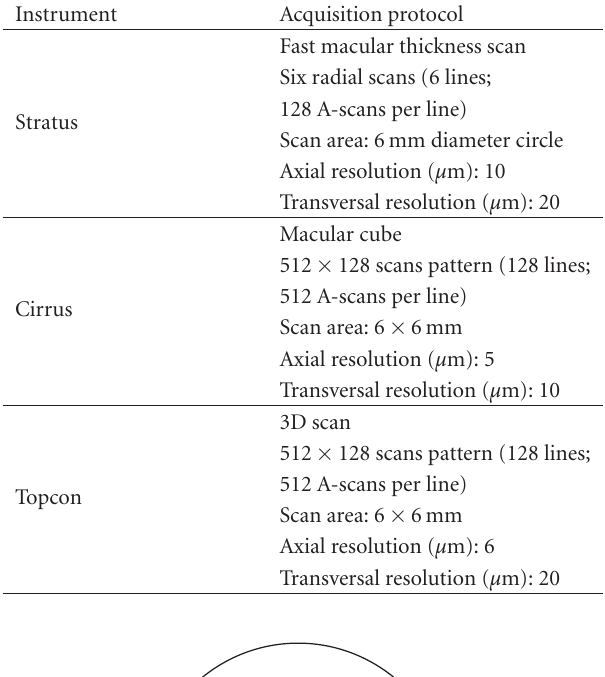
Table 1: Description of acquisition protocols for each OCT device.